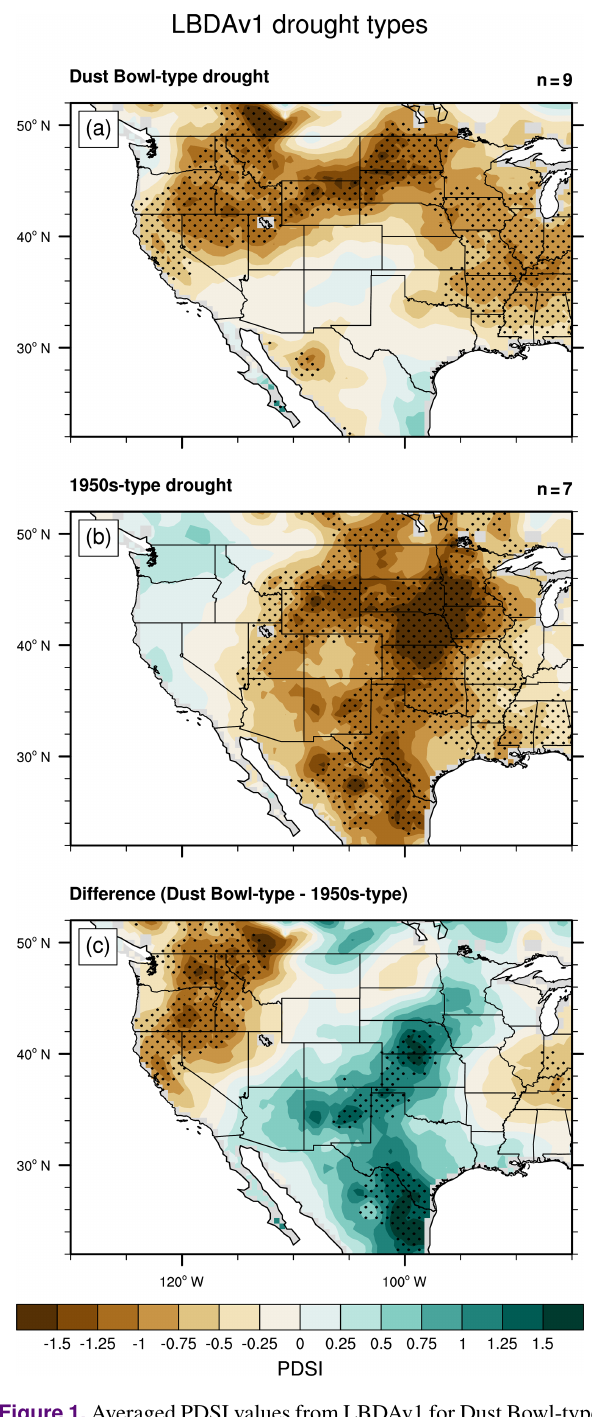
Figure 1. Averaged PDSI values from LBDAv1 for Dust Bowl-type droughts (a) and 1950s-type droughts (b) since 1600. The differ- ence between Dust Bowl and 1950s types is shown in (c) . Stippling indicates significance at the 95% level based on a non-parametric Wilcoxon–Mann–Whitney